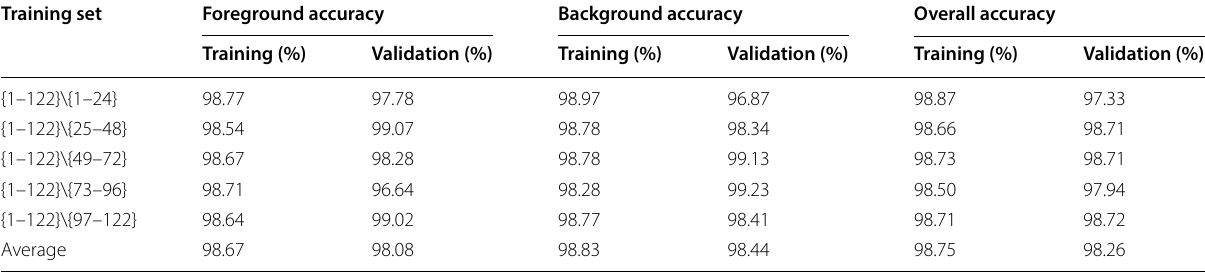
Table 1 Fivefold cross-validation on bright-field training sets Training set Foreground